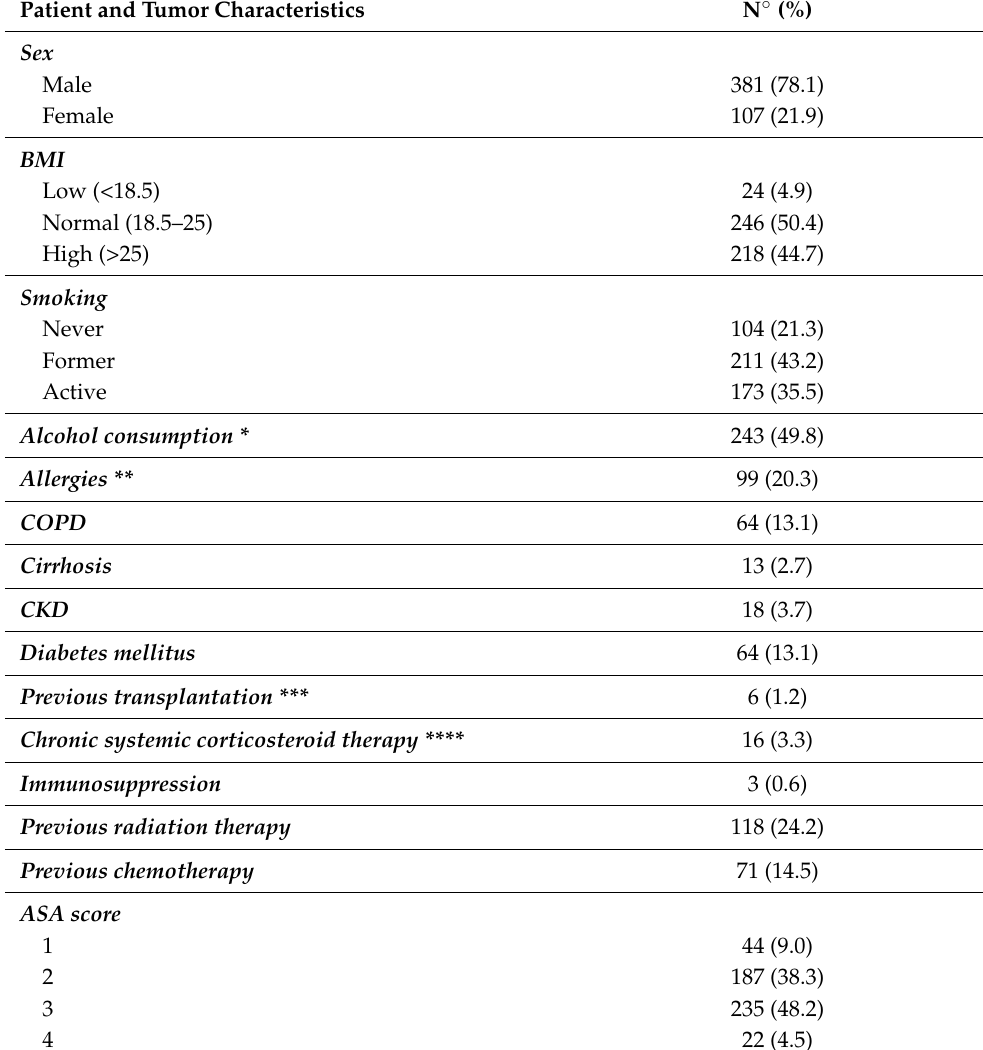
Table 1. Patients’ characteristics.